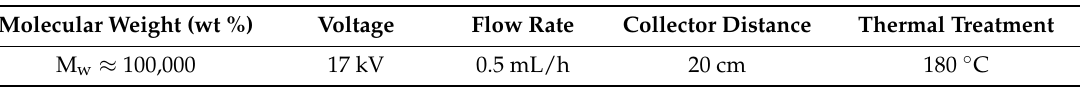
Table 1. The summary of the experimental conditions used for the fabrication of the electrospun fibers.